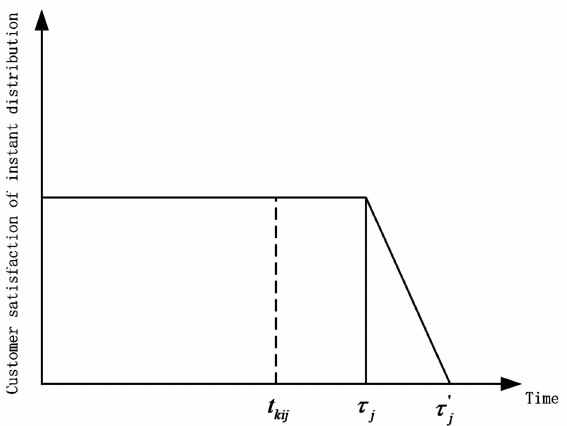
Figure 2. Time window of customer